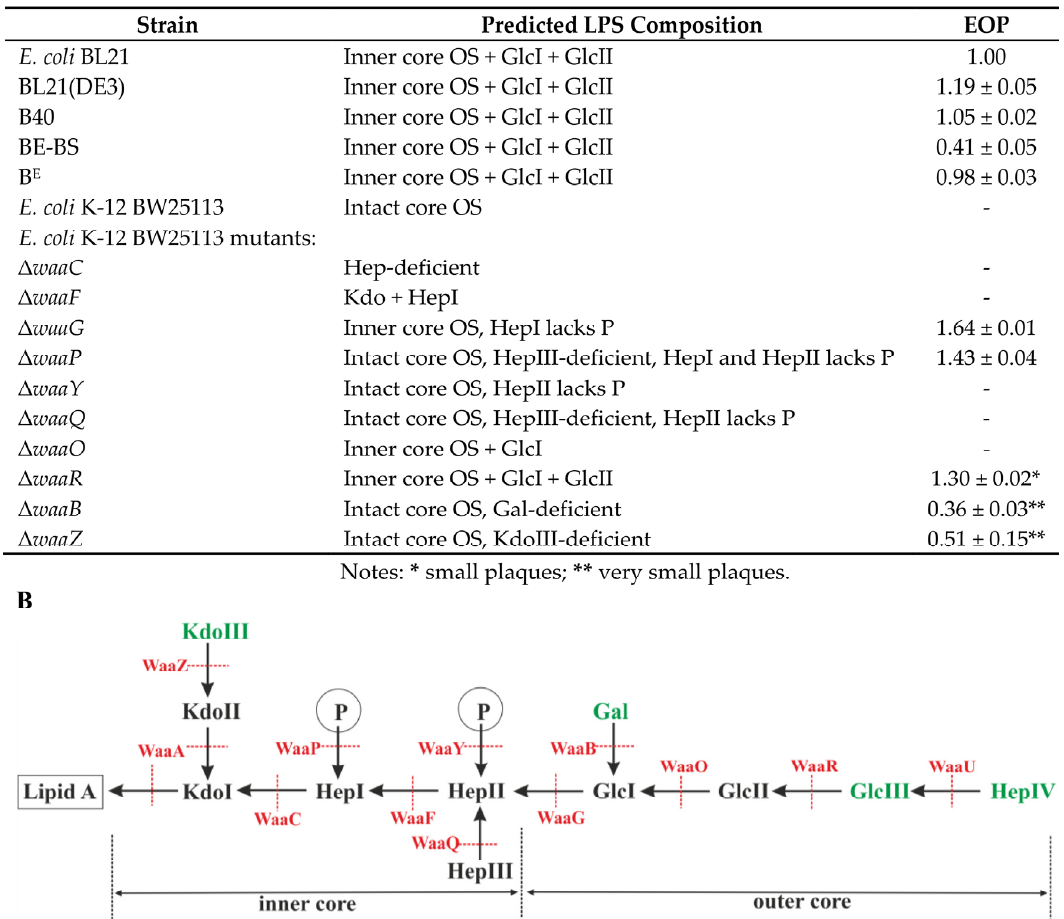
Figure 7. Plating efficiency of VpaE1 on different E. coli strains at 37 °C ( A ); and schematic representation of the LPS structure of E. coli K-12 ( B ), adapted based on the data from [4,12,13,62 – 66]. Residues shown in black are shared between E. coli K-12 and E. coli B LPS.